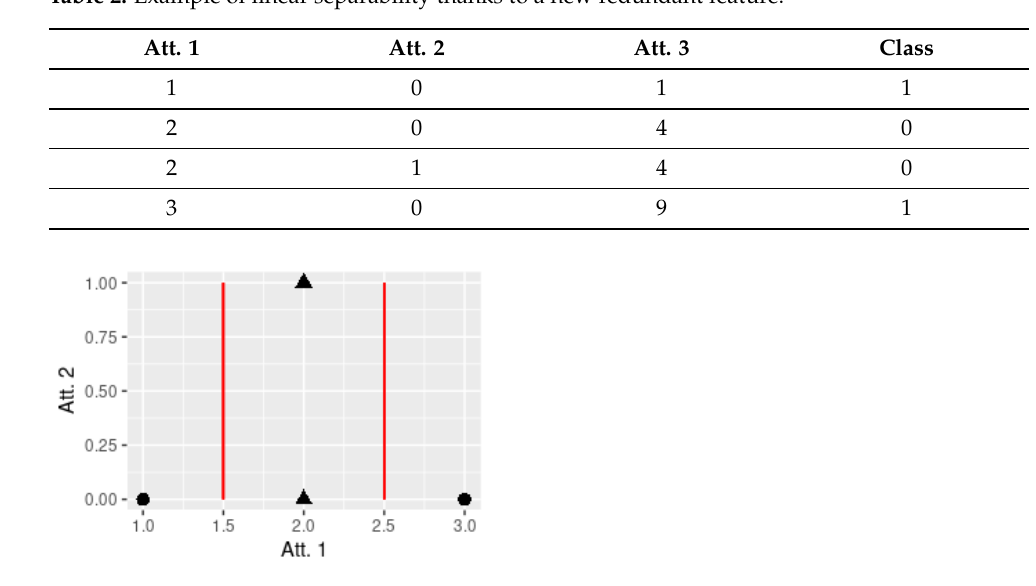
Figure 1. Graph corresponding to Table 2 without feature